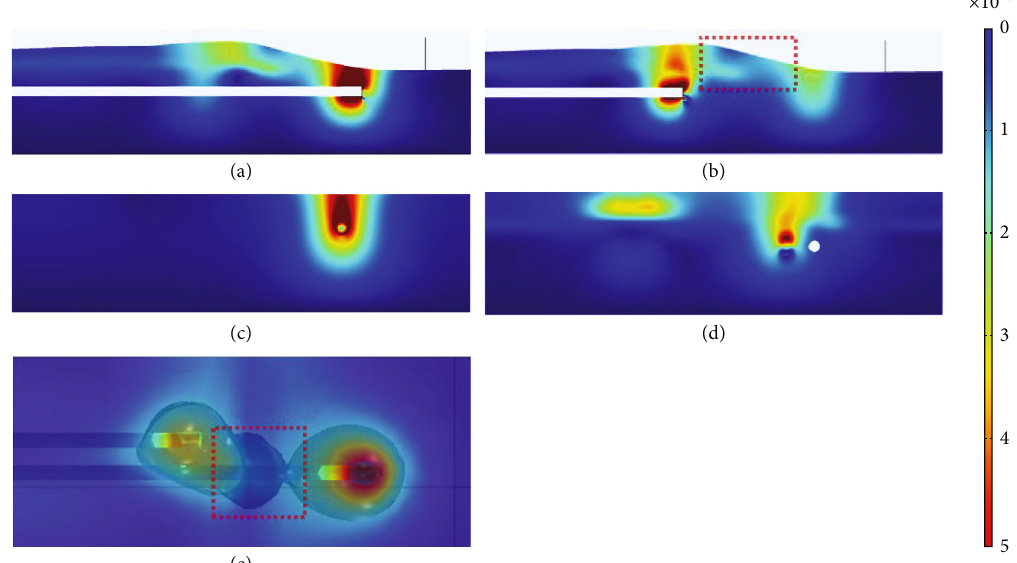
Figure 11: Displacement diagram of the model calculation results of the left shield crossing the fl ood control levee: (a) longitudinal section of the right line tunnel; (b) longitudinal section of the left line tunnel; (c) cross-section of the right line tunnel palm face; (d) cross-section of the left line tunnel palm face; (e) top view of the tunnel model